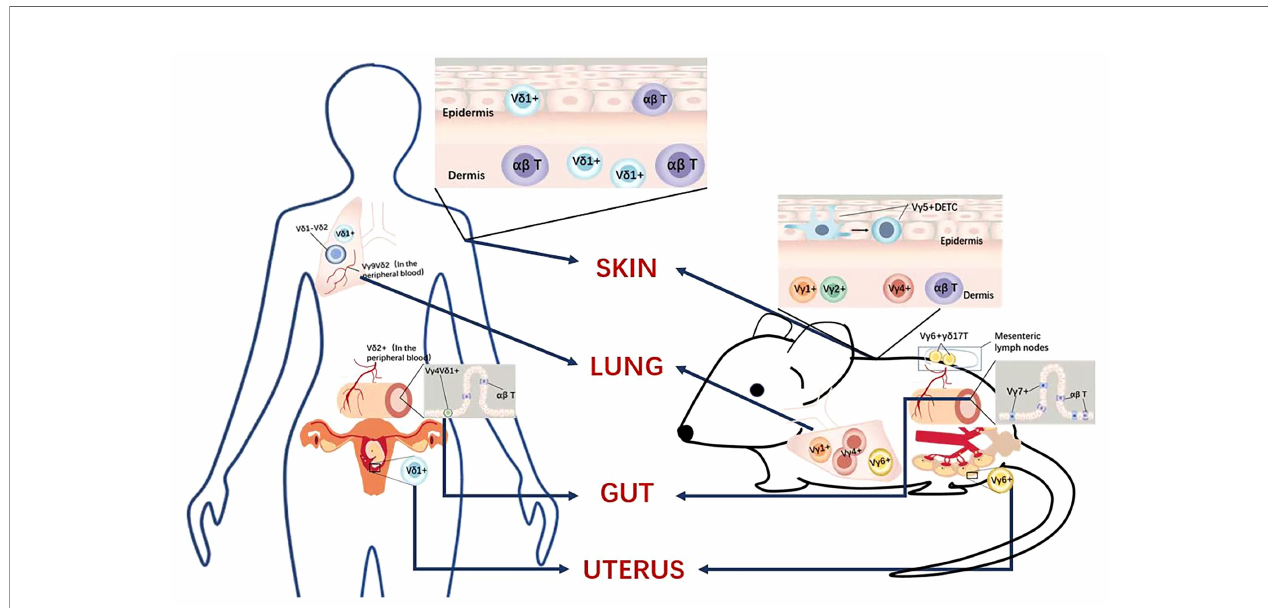
FIGURE 2 | Tissue-resident gd T cell subsets, comparing humans and